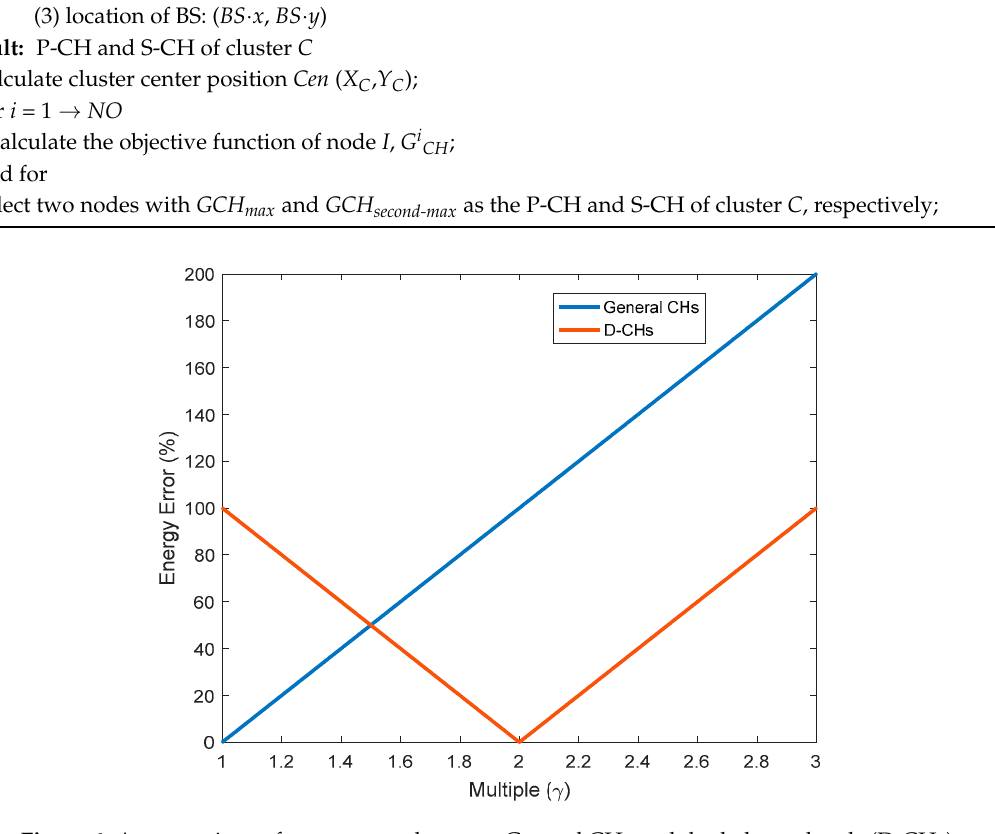
Figure 6. A comparison of energy error between General CHs and dual-cluster heads (D-CHs).